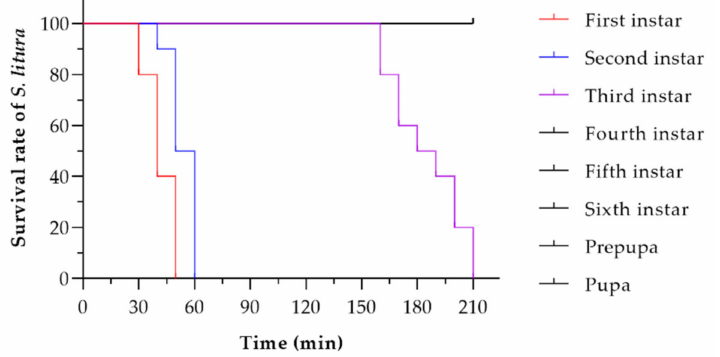
Figure 2. Survival rates of individual first to sixth instar larva, prepupa, and pupa of Spodoptera litura parasitized by individual Pyemotes zhonghuajia up to 720